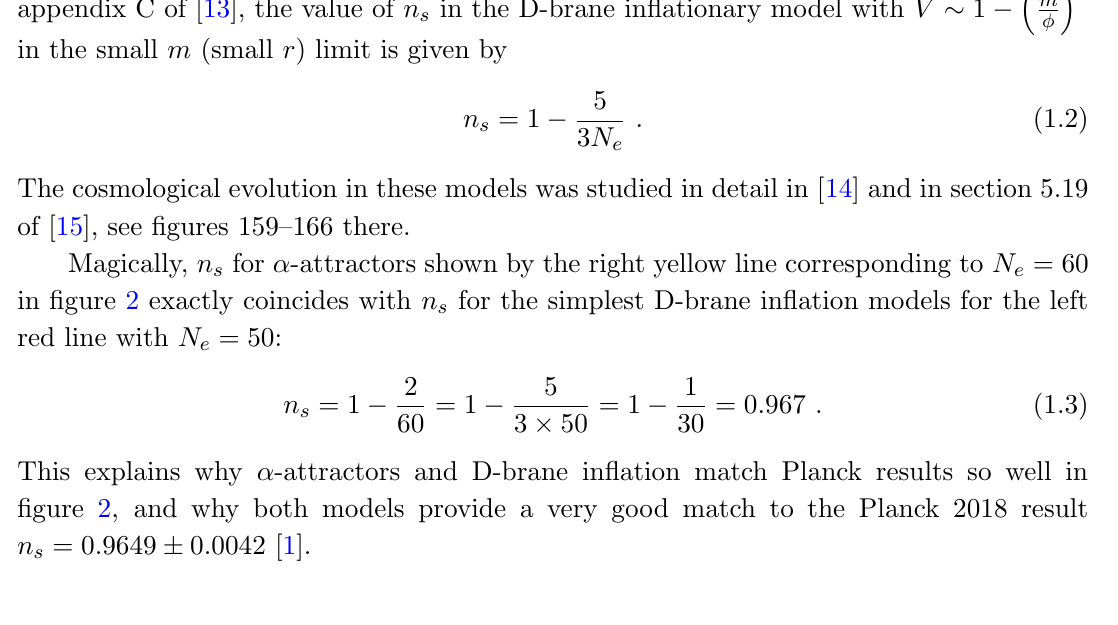
4 m (cid:30) (cid:0) (cid:16) (cid:17)